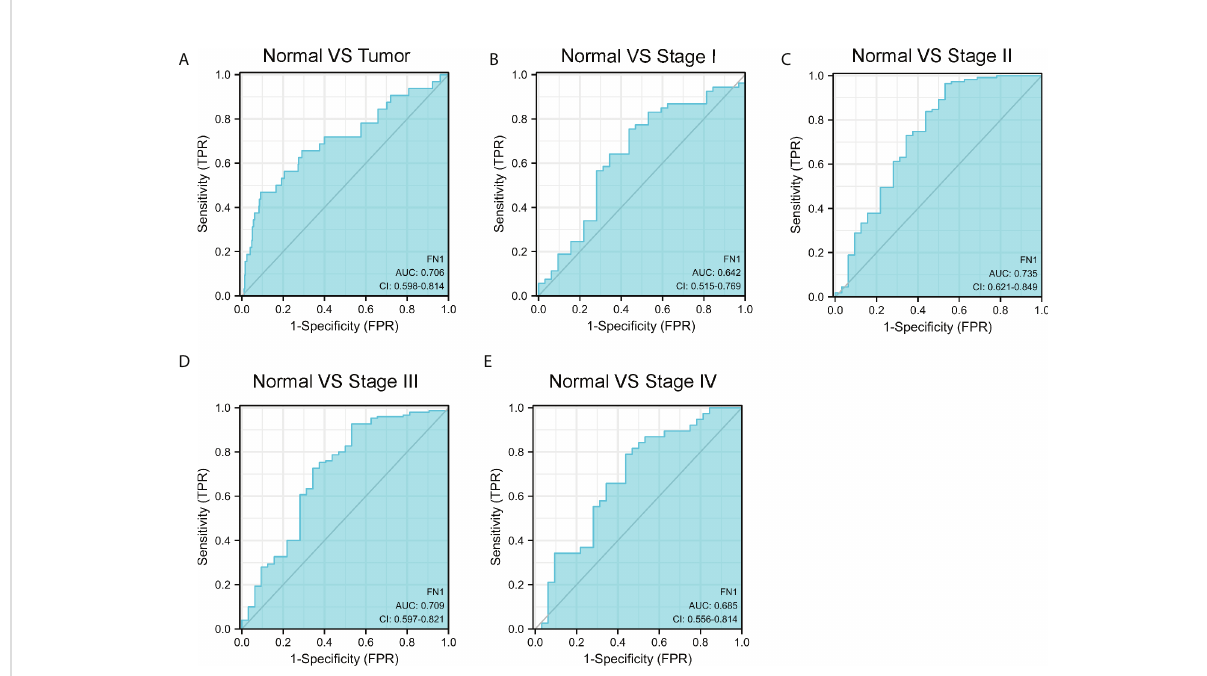
FIGURE 2 ROC curve of FN1 mRNA expression in STAD cohort. (A) ROC curve of FN1 mRNA expression in normal and tumor. (B – E) Subgroup analysis for stages I, II, III, and IV, respectively.